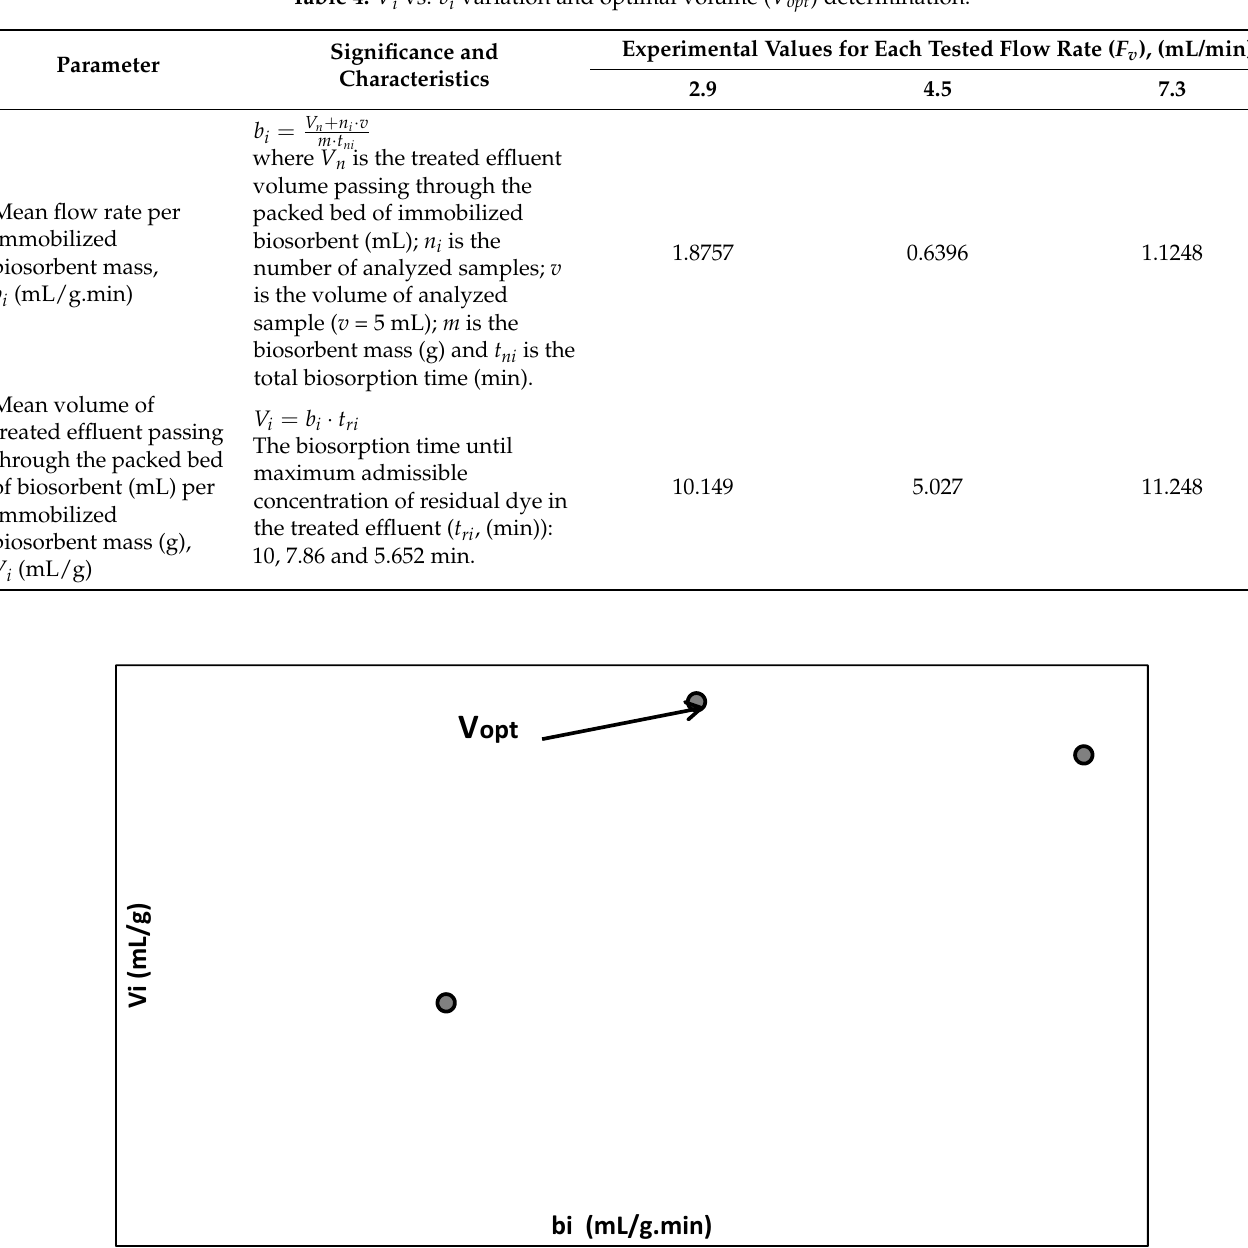
Figure 4. Graphical representation of V i versus b i for determination of V opt . Table 4. V i vs. b i variation and optimal volume ( V opt ) determination.